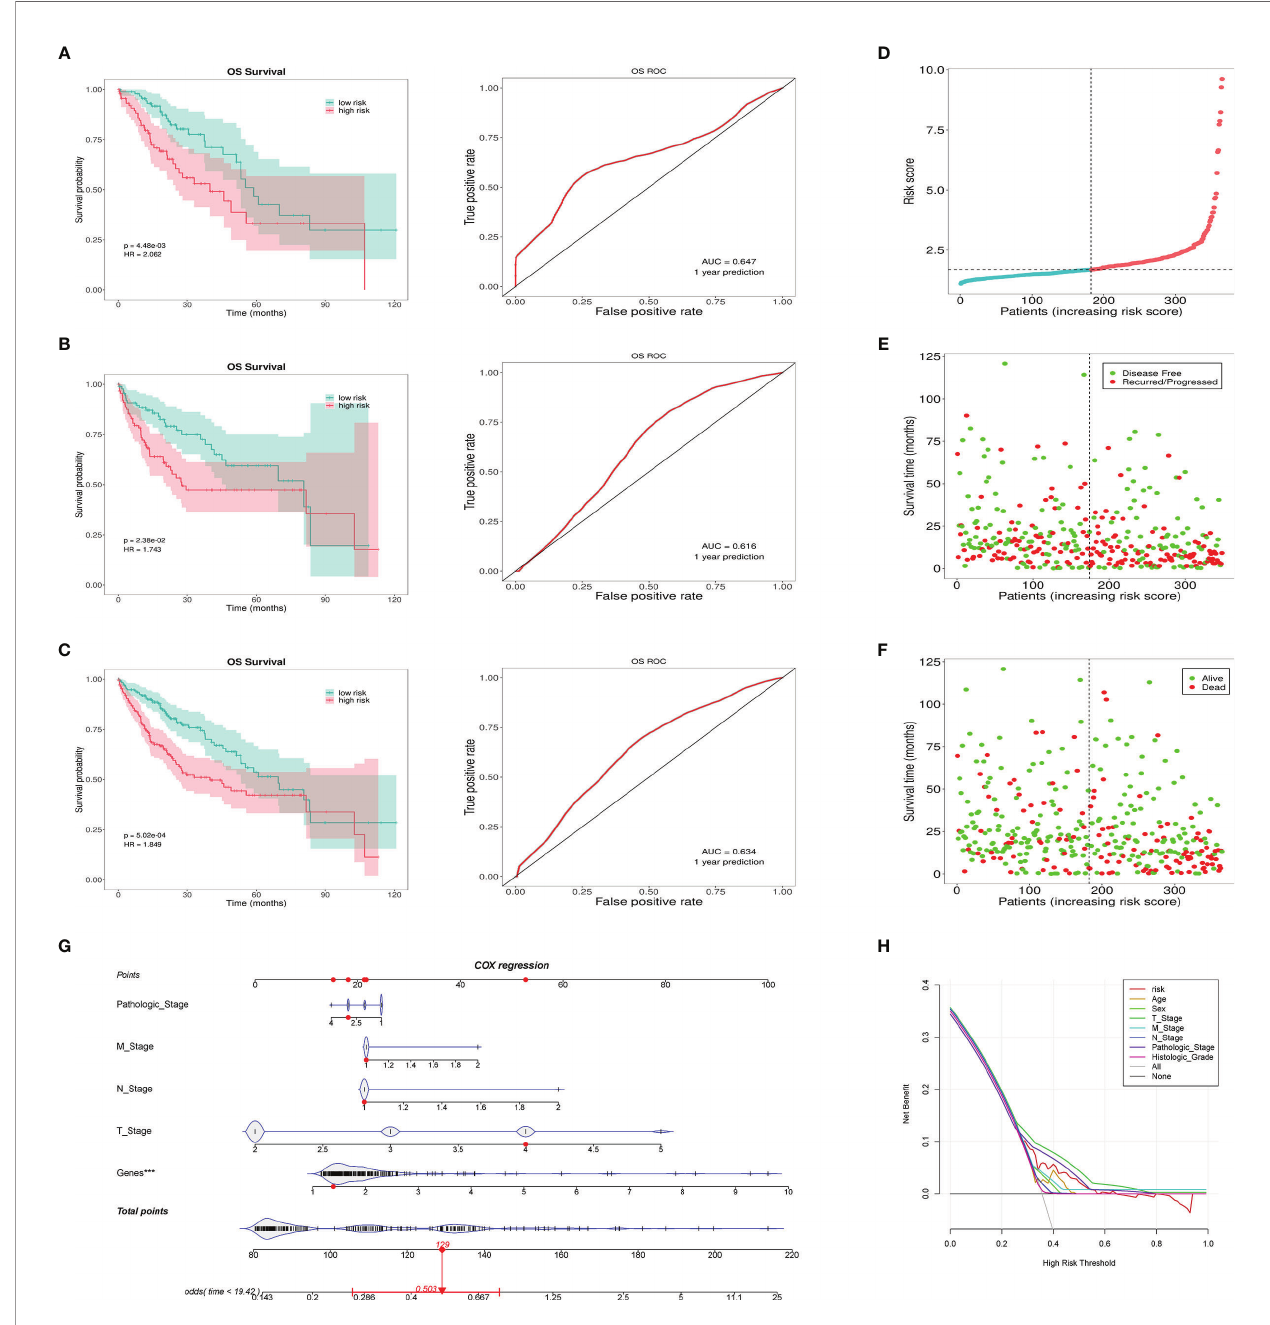
FIGURE 4 | This prognostic signature predicts differences in prognosis between the high- and low-risk groups. (A) The survival curves of the high- and low-risk groups in the training set and the corresponding 1-year ROC curves. (B) The survival curves of the high- and low-risk groups in the testing set and the corresponding 1-year ROC curves. (C) The survival curves of the high- and low-risk groups in the total cases and the corresponding 1-year ROC curves. (D) Risk score distribution of patients in the high- and low-risk groups. (E) Distribution of the overall survival status among HCC patients with an increased risk score. (F) Distribution of recurrence patients among HCC patients with an increased risk score. (G) Nomogram predicting the OS for HCC patients. The short black line and the blue fi ddle box represent the data distribution. Genes refers to the risk value calculated by the signature. The red dots indicate the example. The red line represents the con fi dence interval of OS of the example. (H) DCA curve shows the signature has clinical value, but it is not better than the T stage and pathologic stage. ***p < 0.001, means the risk score of the lncRNAs is an independent